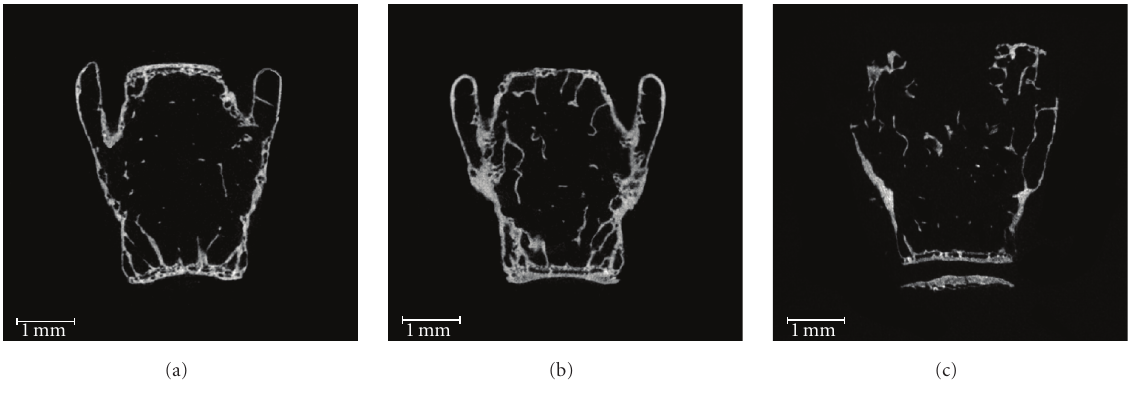
Figure 3: Representative two-dimensional frontal planar μ CT images showing changes in bone integrity of the fifth vertebral body of VCD- treated and ovariectomized mice. Aged C57BL/6Hsd female mice (9–12 months old) were dosed daily for 15 days with sesame oil (vehicle; CON) or VCD (160 mg/kg) or ovariectomized on d35 after the start of the experiment. Trabecular bone microarchitecture of the fifth vertebral body was assessed by μ CT on samples collected at 5-month postovarian failure (age: 18.8 months; d181) as described in Section 2. Shown are representative images of vertebral bodies excised from: (a) a cycling control-treated, (b) a VCD-treated, and (c) an ovariectomized animal. The scale bar represents 1.0 mm in all